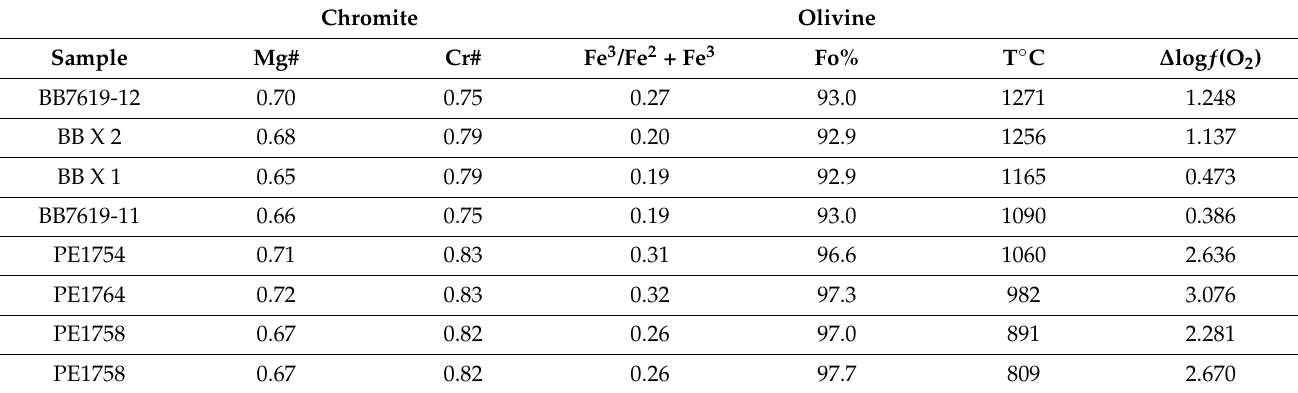
Table 5. Temperature and oxygen fugacity for chromite–olivine pairs from the Kraka chromitites. Chromite